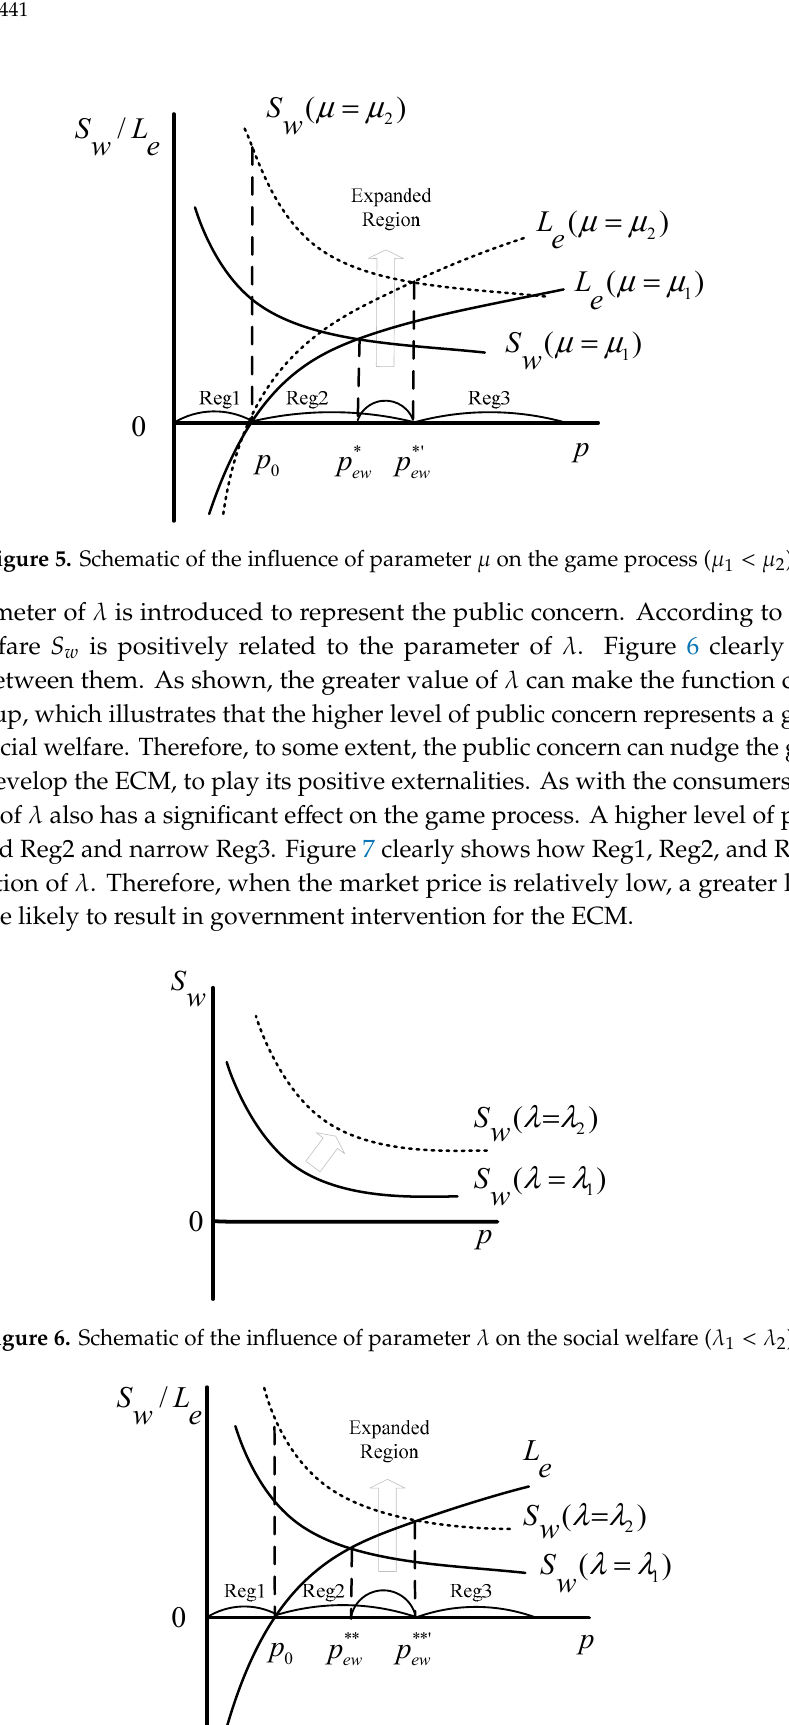
μ on the investors’ profits and social welfare (